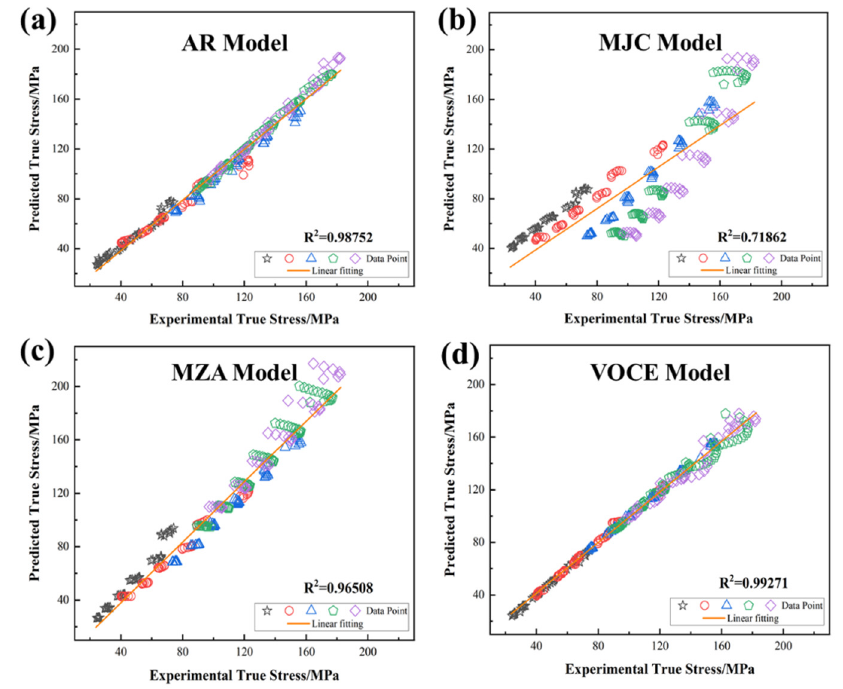
Figure 15. Comparison of correlation coefficients of prediction stress by different models ( a ) AR Model; ( b ) MJC Model; ( c ) MZA Model; ( d ) VOCE Model.